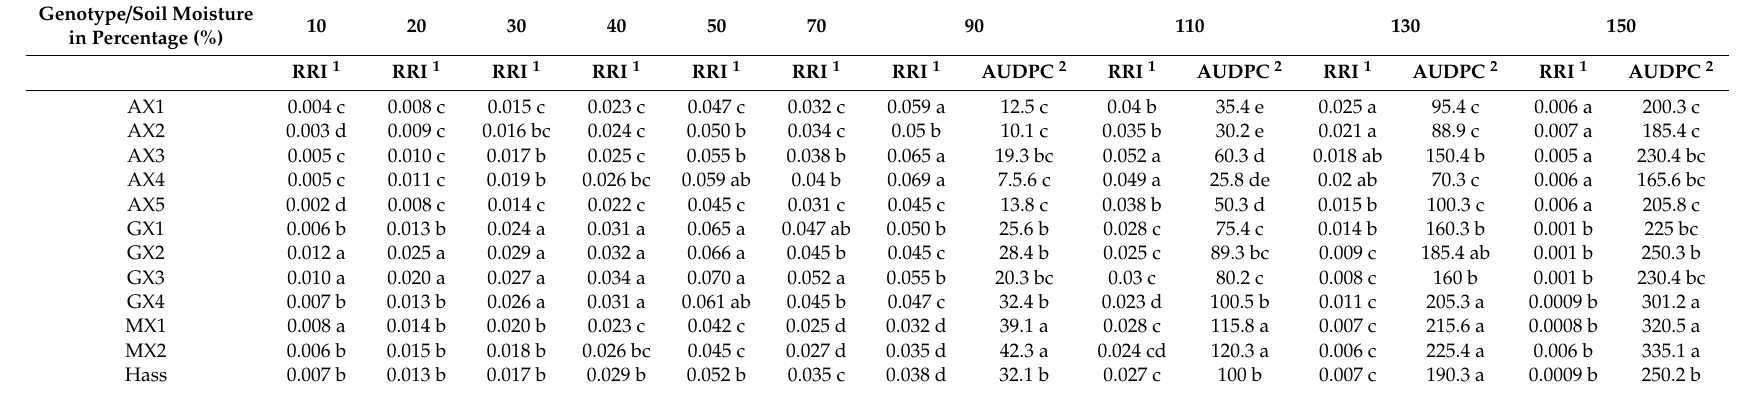
Table 1. Adaptability of native avocado rootstocks to di ff erent soil moisture